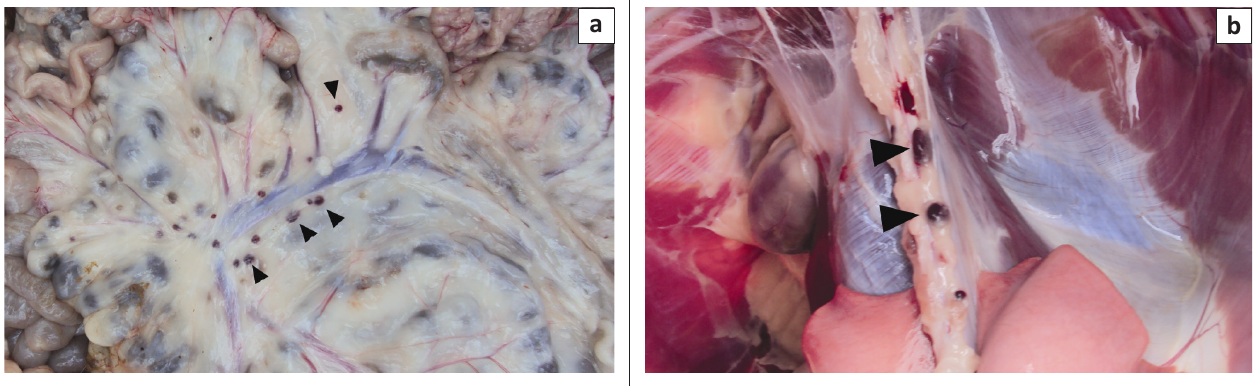
FIGURE 2: Congested lymph nodes in the (a) respiratory and (b) gastrointestinal systems of PPR-suspected animals (see arrow heads).